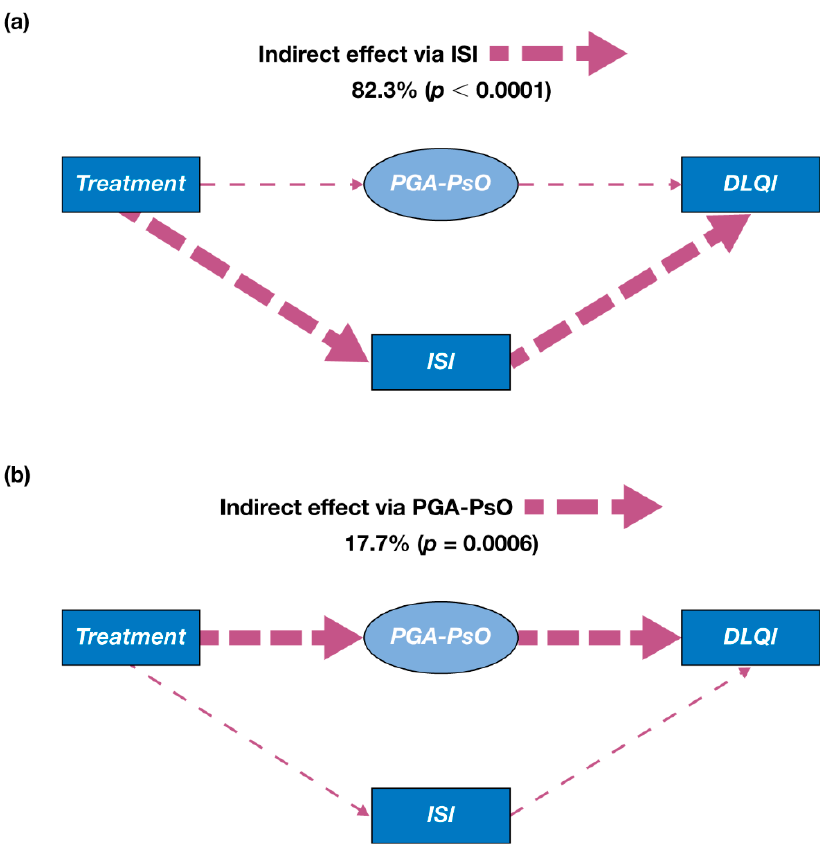
Figure 3. Effects of tofacitinib treatment on DLQI in the re-specified mediation model (pooled data from OPAL Broaden and OPAL Beyond). ( a ) Indirect effect via itch (measured by ISI); ( b ) indirect effect via PGA-PsO. Treatment was represented by a binary variable (tofacitinib 5 mg twice daily [value of 1] versus placebo [value of 0]); the model included mean scores of each outcome from Months 1 and 3 for every patient with available data from OPAL Broaden or OPAL Beyond; PGA-PsO was a latent variable represented by means of erythema, induration, and scaling.